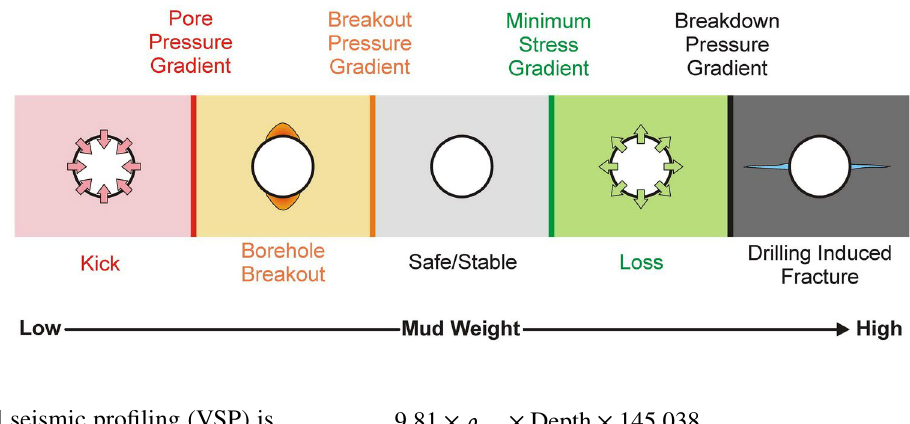
Fig. 4 Concept of safe Mud Weight windows for drilling (Le and Rasouli 2012)